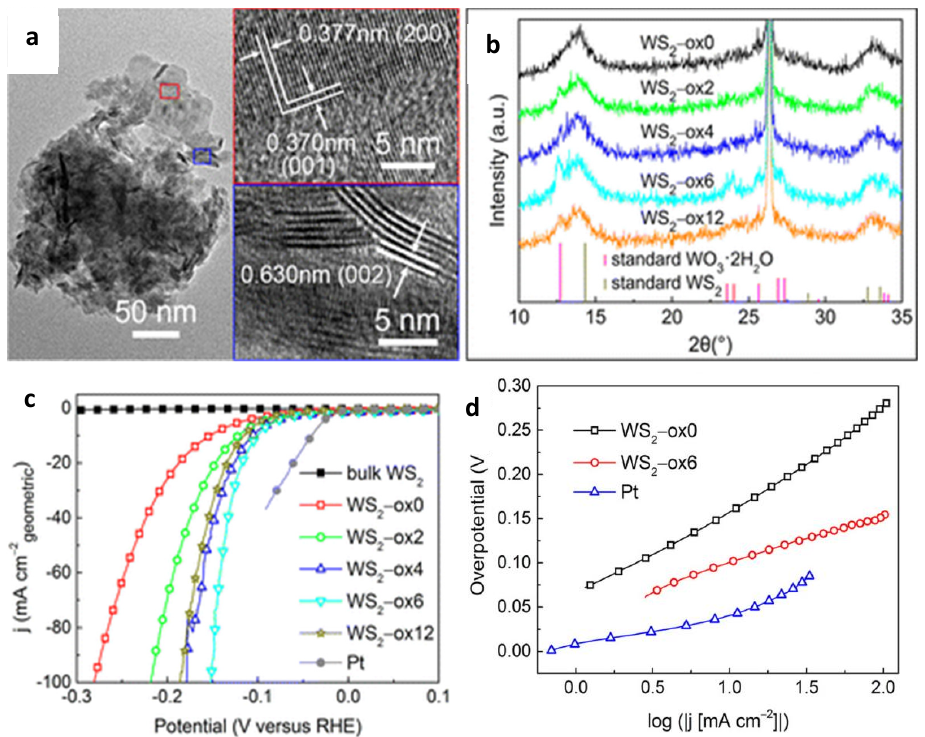
Figure 7. ( a ) TEM image of the WS 2 –ox6heterostructure. The red and blue squares correspond to the WO 3 and WS 2 regions, respectively. ( b ) XRD patterns of the different obtained heterostructure. ( c ) LSV of WS 2 with different degrees of anodization at 600 ◦ C. ( d ) Tafel slop of two different oxidation degrees of WS 2 and a Pt wire sample. Reproduced with permission [141]. Copyright 2016, American Chemical Society.